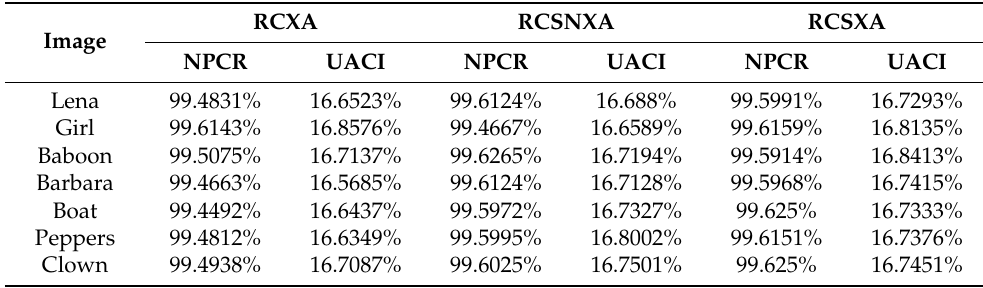
Table 2. NPCR and UACI